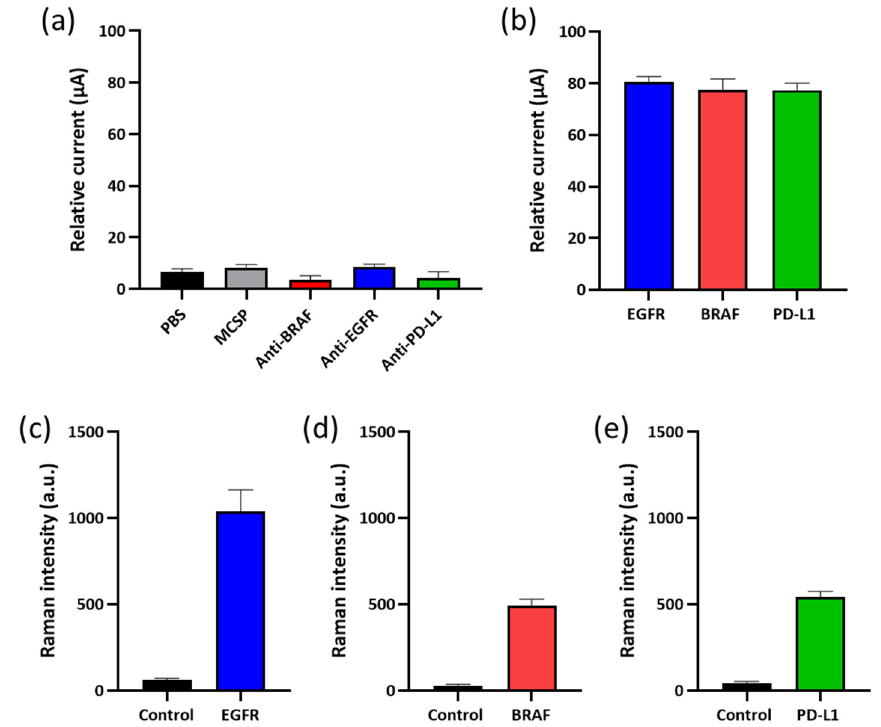
Figure 2. Detection specificity of dual detection biosensor platform. ( a ) presents the relative adsorption data for different control experiment where the current reduction was negligible (>10%). ( b ) shows the observed DPV current reduction for 100 pg (10 ng/mL) target protein capture. The error bars represent the standard deviation from three replicate runs. SERS intensities for positive detection of EGFR (100 pg) and its control intensity (i.e., no EGFR protein) is presented in ( c ). ( d , e ) represents the SERS intensities of positive experiments with BRAF and PDL-1 proteins (100 pg) in respect to their control experiments (i.e., no targets), respectively. (n = 3) The error bars represent the standard error from three replicate runs.